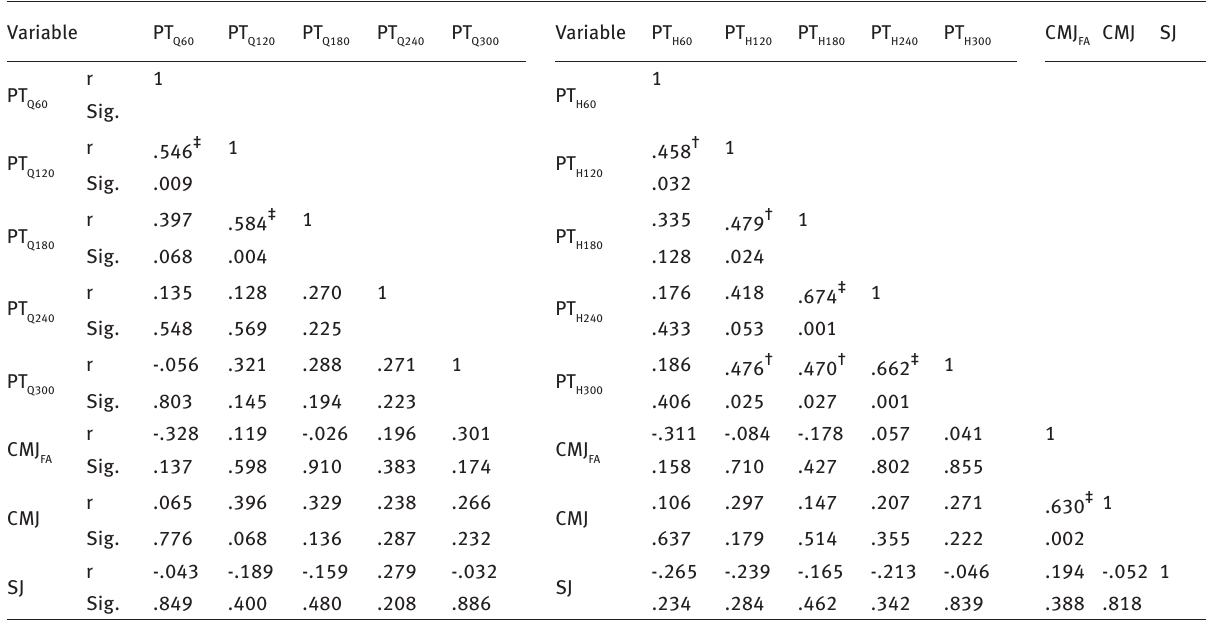
Table 5: Correlations between bilateral strength imbalances in the monitored variables.